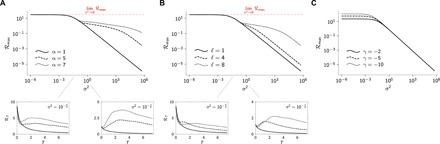
Maximum information rate versus noise level for chain network.(A) Plot of ℛmax = maxT≥0 ℛT versus the output noise variance for the network of Fig. 3A with B = C = I, γ = − 2.5, ℓ = 8, and three different values of α. (B) Plot of ℛmax versus the output noise variance for the network of Fig. 3A with B = C = I, γ = −2.5, α = 5, and three different values of ℓ. (C) Plot of ℛmax versus the output noise variance for the network of Fig. 3A with B = C = I, α = 1, ℓ = 8, and three different values of γ.